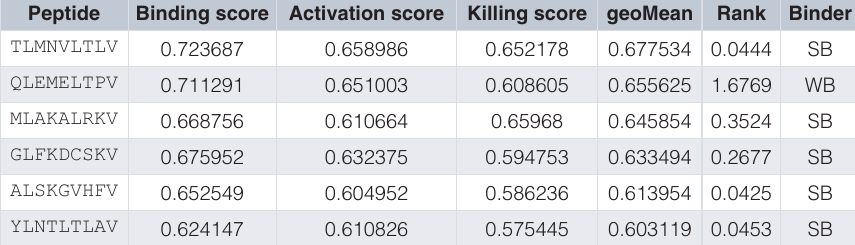
Table 5. 2019-nCoV 9-mer peptides having leucine-valine in anchor positions. Peptides have geometric mean ≥ 0.6 and ≤ 0.7 (for those ≥ 0.7, refer to Table 4) by 1G4 TCR